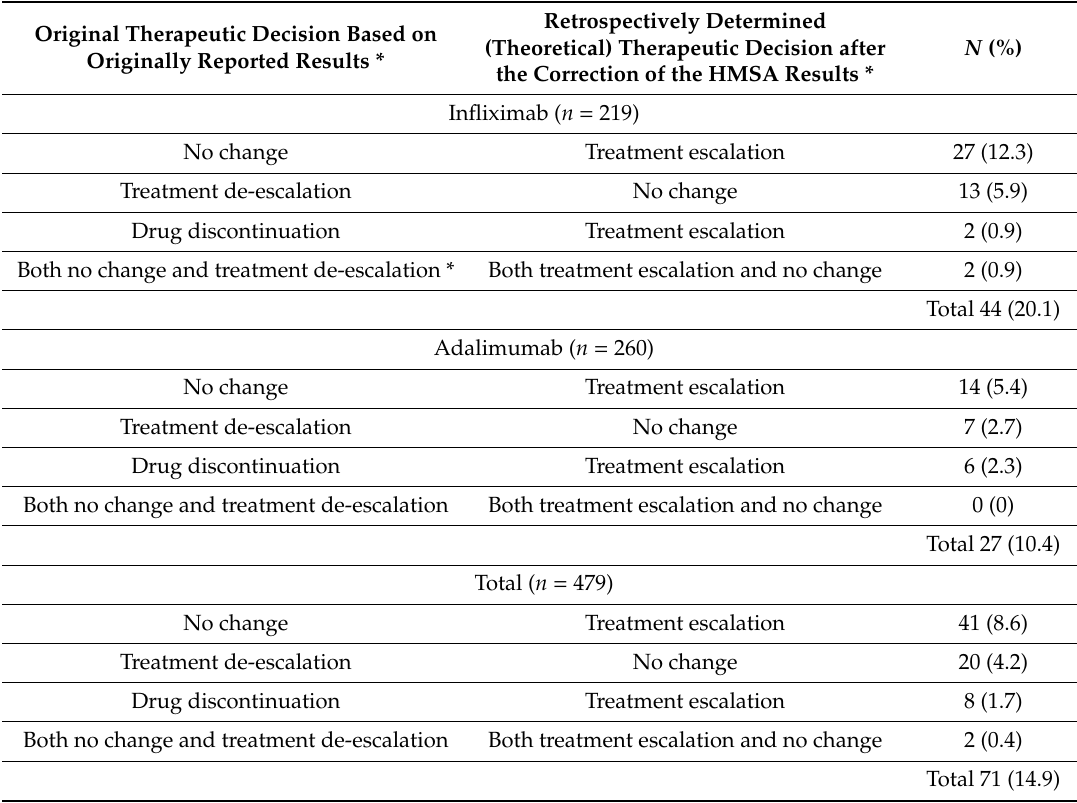
Table 2. A per patient analysis of therapeutic discrepancies noted after reporting of corrected results. Retrospectively Determined Original Therapeutic Decision Based on Originally Reported Results *